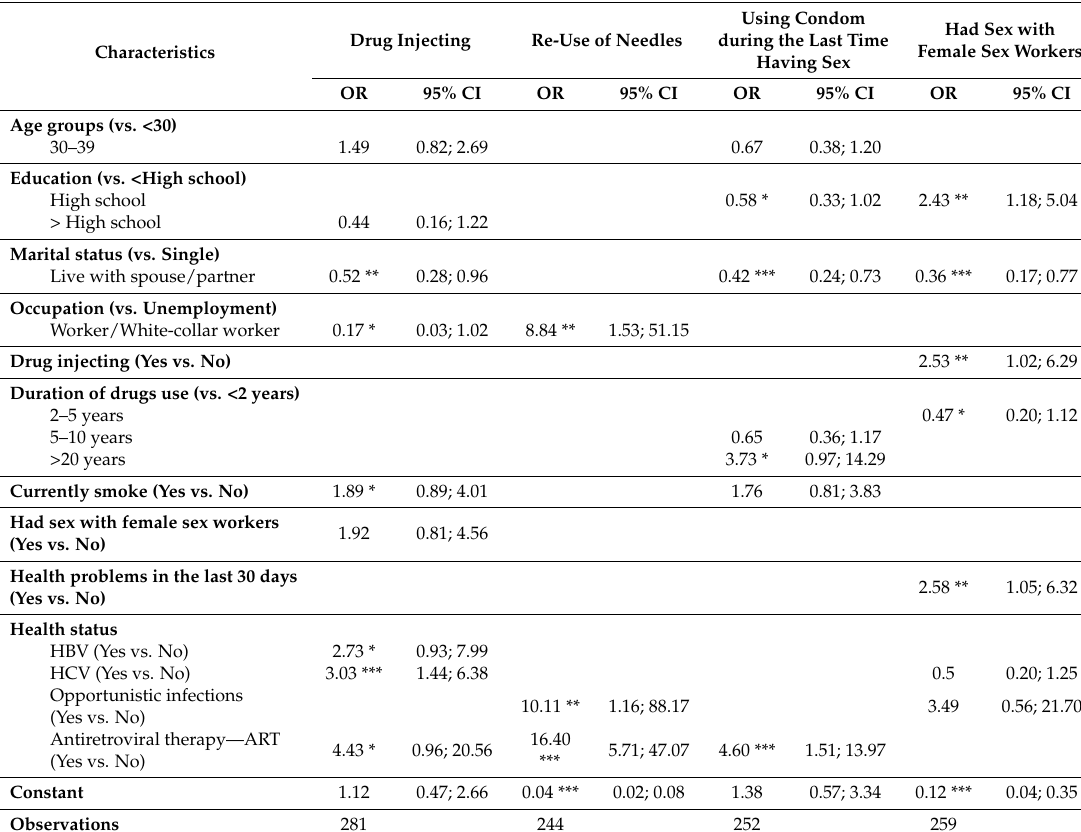
Table 5. Factors related to substance use and sexual risk behavior among drug